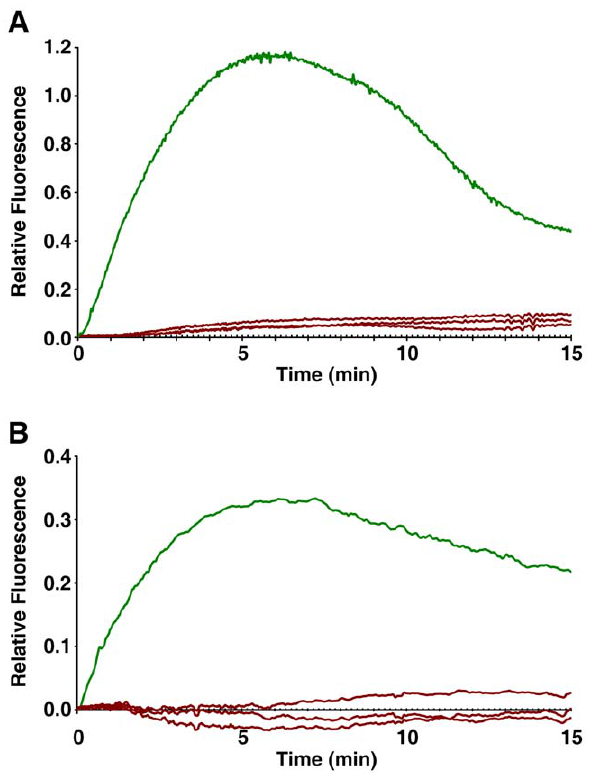
Figure 5. The mature eggs pretreated with ionomycin at the GV stage respond to the second dose of ionomycin or A23187 with no intracellular Ca 2 + increase. P. miniata oocytes at the GV stage were briefly exposed to 5 m M ionomycin and switched to the normal seawater containing 10 m M 1-MA for 1 h and subsequently challenged with the second dose of 5 m M ionomycin ( A ) or 40 m M A23187 ( B ). In both cases, the green curves depict the Ca 2 + response in the control eggs, and the brown ones the response of the eggs that had been briefly exposed to 5 m M ionomycin at the GV stage.